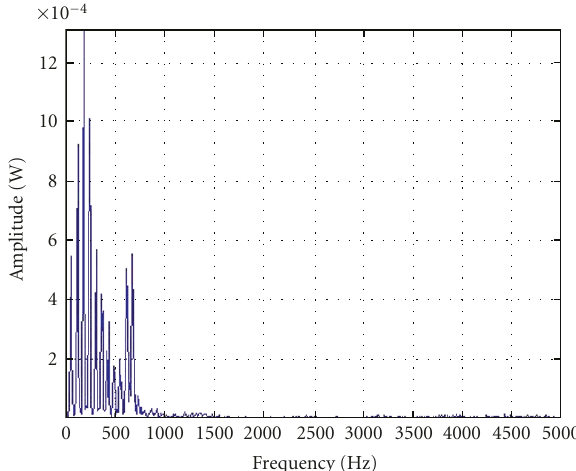
Figure 10: Pressure and voice signal amplitudes (cross spectrum) versus frequency